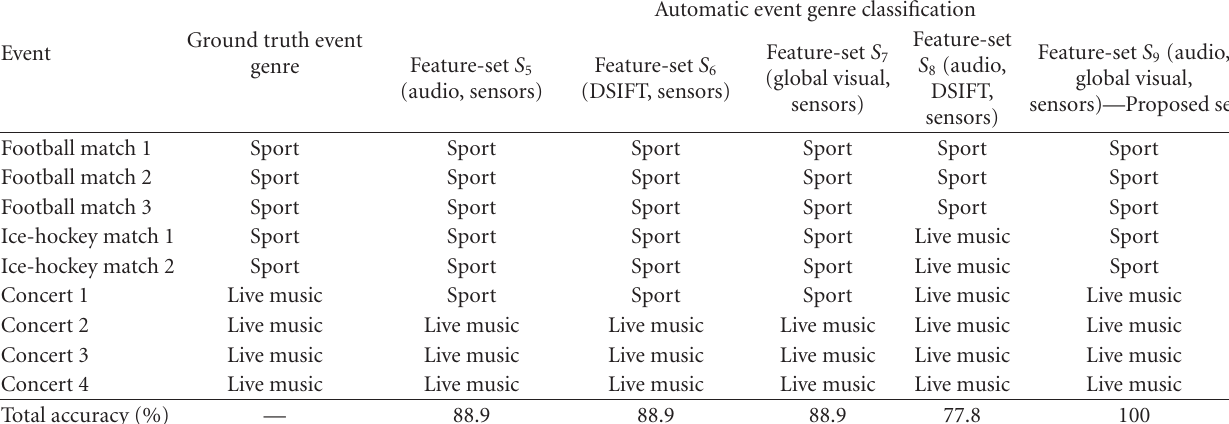
Table 4: Performance comparison for the event genre classification task using di ff erent feature-sets.